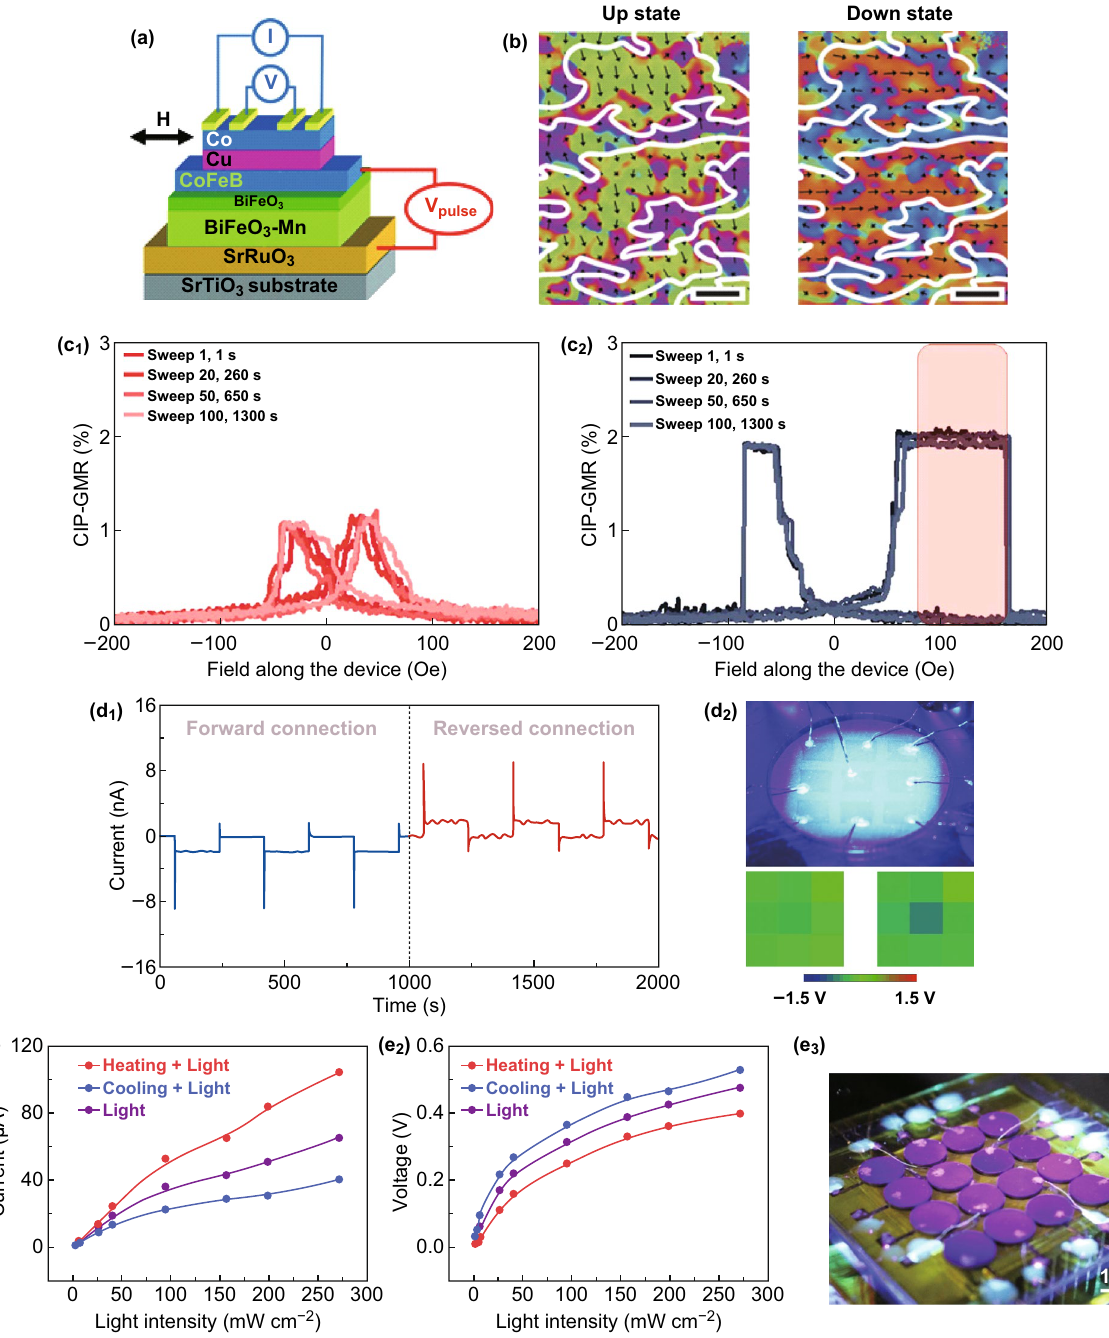
Fig. 7 Application for spintronic and optic devices. a A giant magnetoresistive device based on BFO. Adapted with permission from Ref. [128]. b Exchange coupling between antiferromagnetic order and the ferromagnetic overlayer for BFO‑based spintronic devices. Adapted with permis‑ sion from Ref. [69]. c Voltage‑controlled unidirectional anisotropy for CoFe/BFO heterostructure. A electrically switchable exchange bias is observed at the interface between the BFO and giant magnetoresistance. Adapted with permission from Ref. [108]. d , e Applications in photo‑ detector. d 1 Output current for ITO/BFO/Ag device. d 2 The ITO/BFO/Ag photodetector array. Adapted with permission from Ref. [19]. e Photo‑ voltaic performance of the BFO photodetector modulated by applying different temperatures. Adapted with permission from Ref.